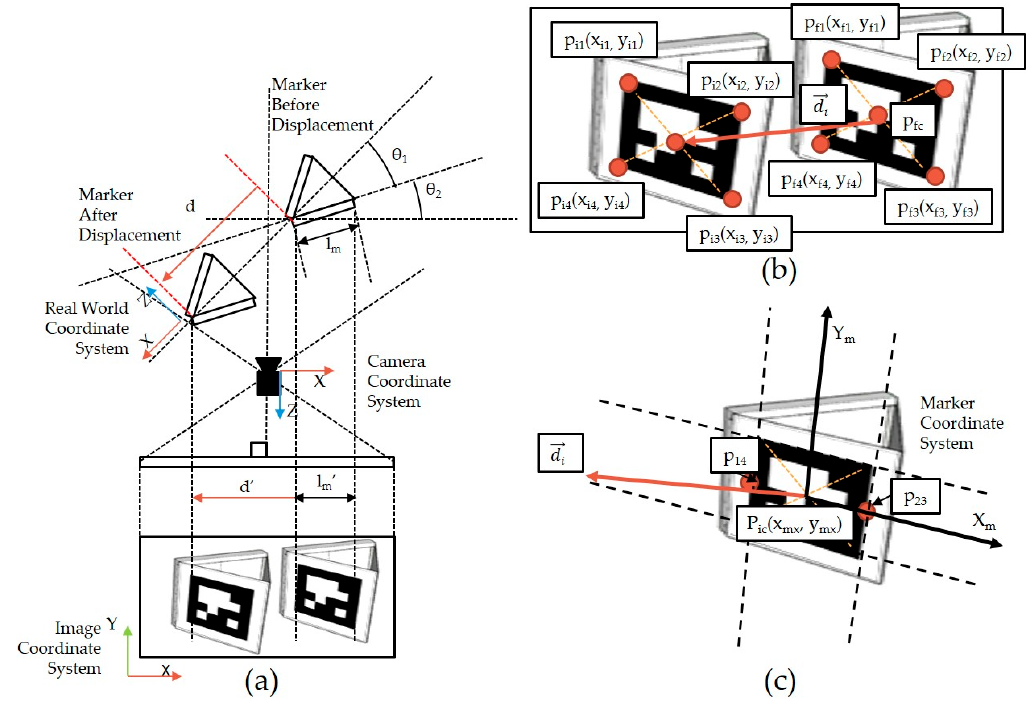
Figure 4. Marker displacement measurement image: ( a ) arrangement of marker, camera, and image during the displacement event; ( b ) coordinates of marker vertices in the image coordinate system before and after the displacement event; ( c ) marker coordinate system in the image.